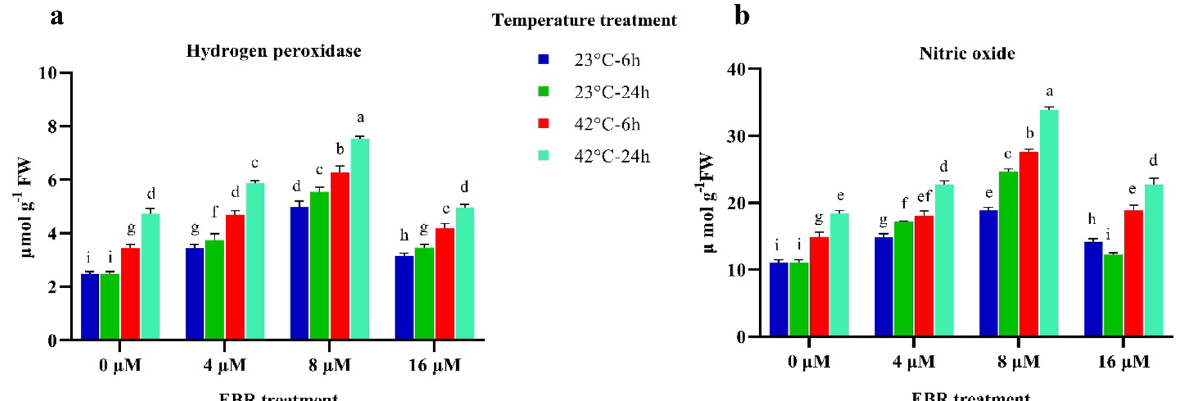
Figure 4. The effects of temperature, harvesting times, and different levels of EBR on H 2 O 2 ( a ), and NO ( b ). Duncan method at a 1% probability level was applied to compare mean values. The columns having similar letters had no significant difference.